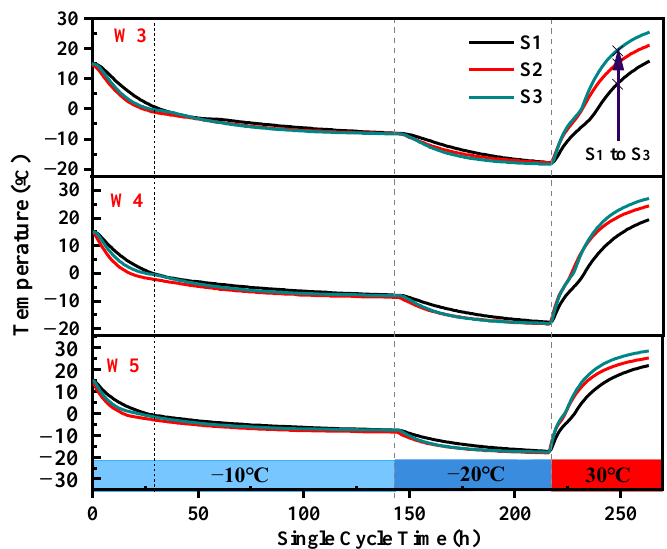
Figure 9. Temperature of slope model in one freeze – thaw cycle.